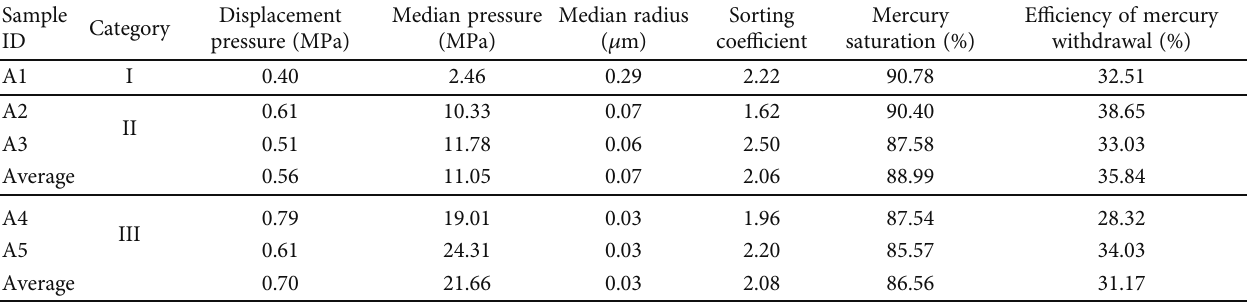
Table 2: Parameters from the HPMI experiment.